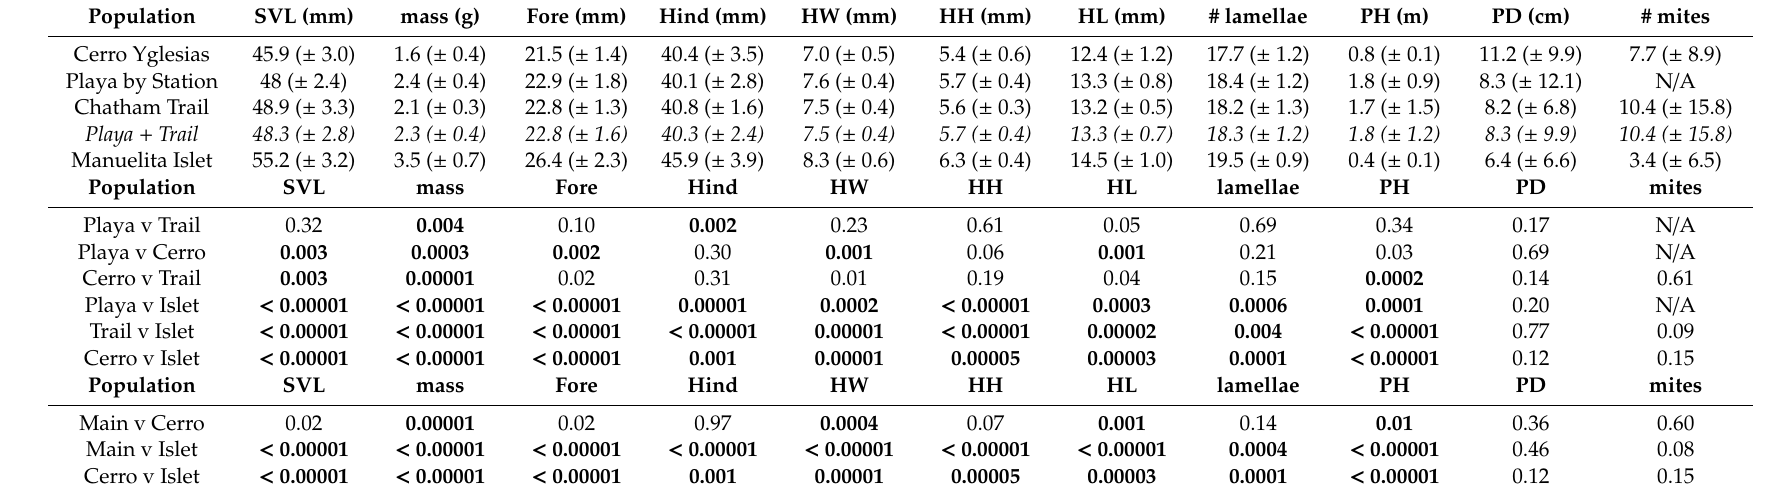
Table 4. ( A ) Average morphological and ecological measurements for four populations of Norops townsendi on Isla Cocos. ( B ) Results for pairwise comparisons of all variables between each population. Significant di ff erences following Bonferroni correction are bolded. ( C ) Results for pairwise comparisons of all variables between each population, while treating the Playa and Trail sites as a single population. Significant values after Bonferroni correction are bolded and italicized. (SVL = snout-vent length, Fore = forelimb length, Hind = hindlimb length, HW = head width, HH = head height, HL = head length, PH = perch height, PD = perch